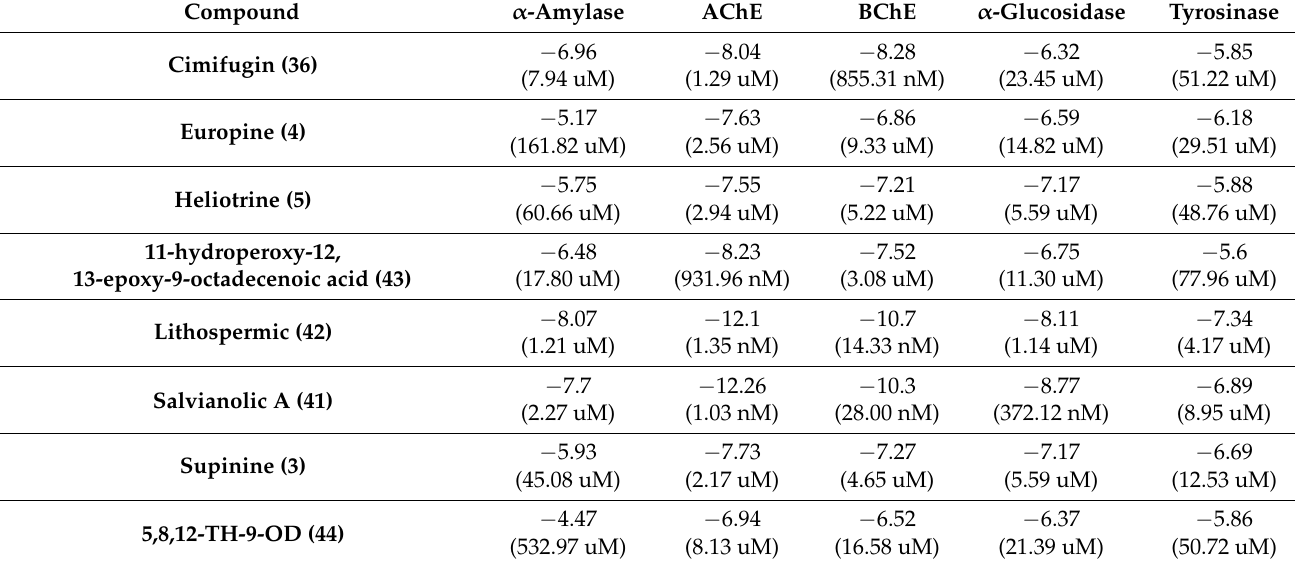
Table 5. Docking free energy in kcal/mol and the calculated inhibition constant of the selected compounds against α -amylase, AChE, BChE, α -glucosidase, and tyrosinase